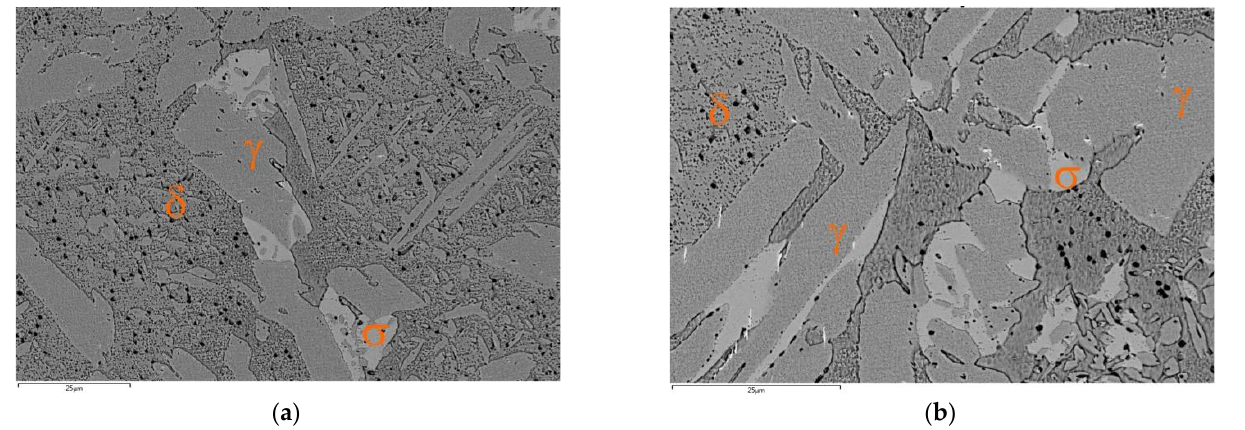
Figure 8. SEM image of tested cast steel after isothermal holding at 900 °C for ( a ) 1 h and ( b ) 3 h.